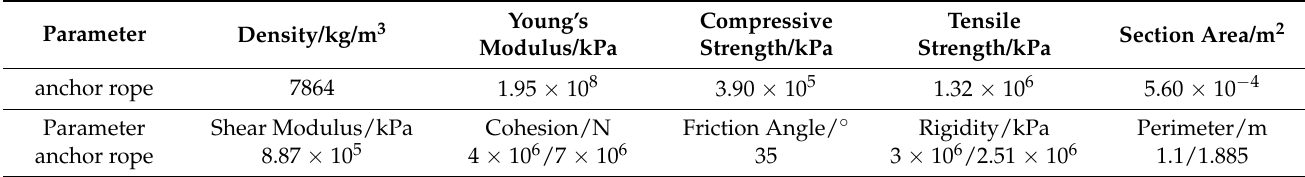
Table 3. Bolt parameters.